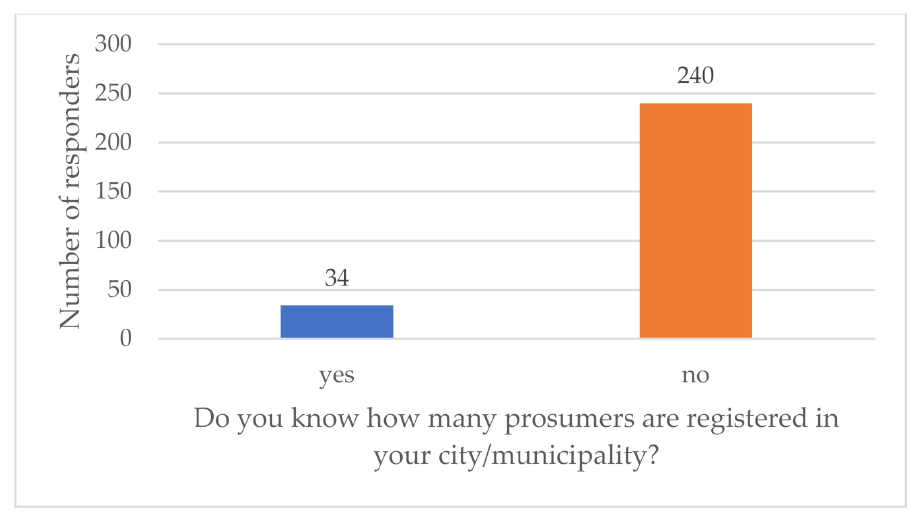
Figure 14. Knowledge of concepts and phenomena. Respondents could select only one answer—‘yes’ or ‘no’. Source: own